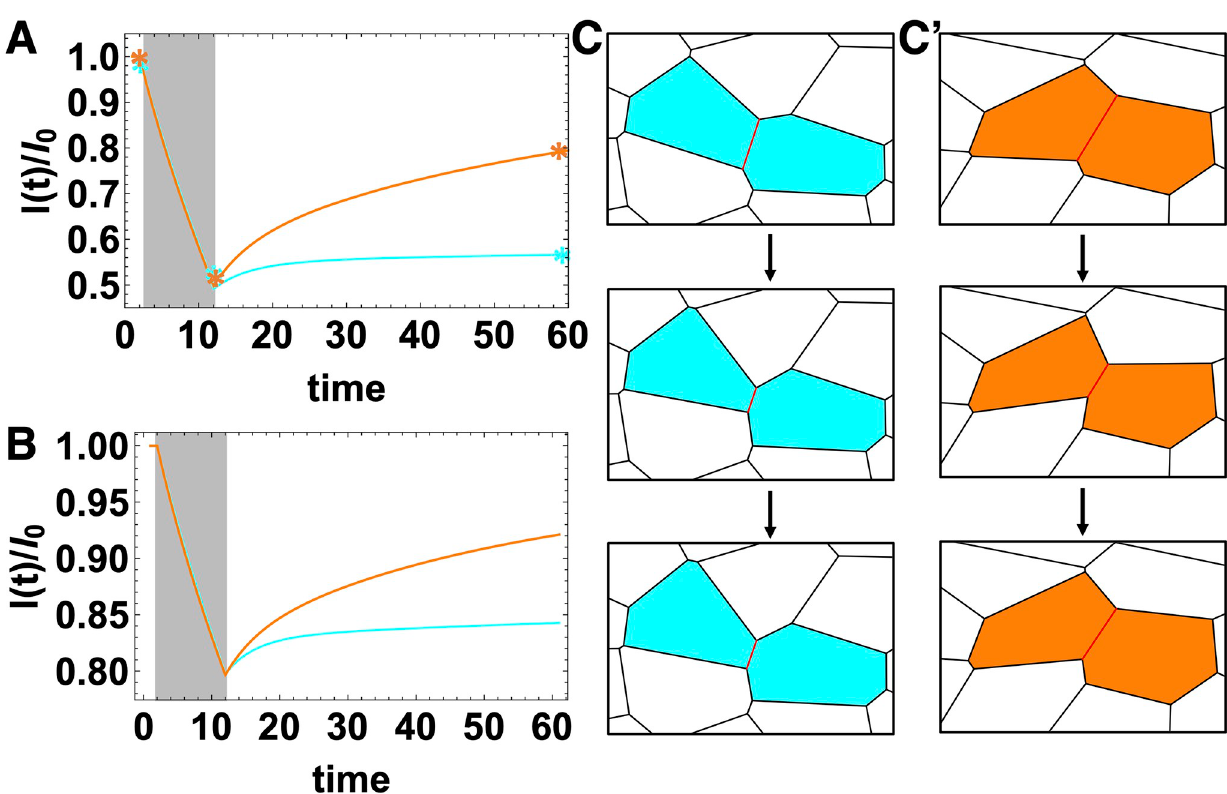
Fig 6. Viscous response of the cellular junctions. (A, B) Junction length, l , normalized by the initial length of the junction l 0 over time in units of simulation time steps, during and after a stress application on an edge in an anisotropic simulation. Grey regions indicate the time period of an high applied stress which shrinks the edge by %50 (A) and a low applied stress which shrinks the edge by %20 (B). The blue curves are from the simulations without a T1 delay, t T 1 = 0 and the orange curves correspond to the simulations with a T1 delay time of t T 1 = 278.2 τ . C) Snapshot from the simulations illustrating the edge dynamics before, during and after the high stress application (asterisks in (A) indicate the exact time points of the snapshots in (C) and (C’)) with t 0 (C) or with t T 1 = 278.2 τ (C’) T1 delay time. Other parameters are γ 0 = 1.0, p 0 = 4.0, T = 0.0 and N =